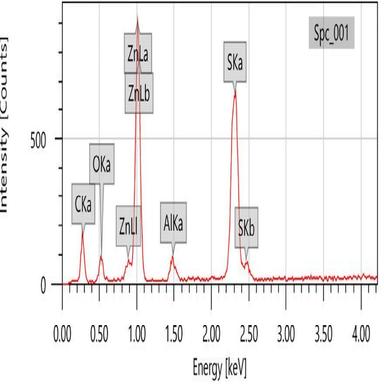
X-Ray Energy Dispersive Spectrum (EDS) of ZnS QDs.